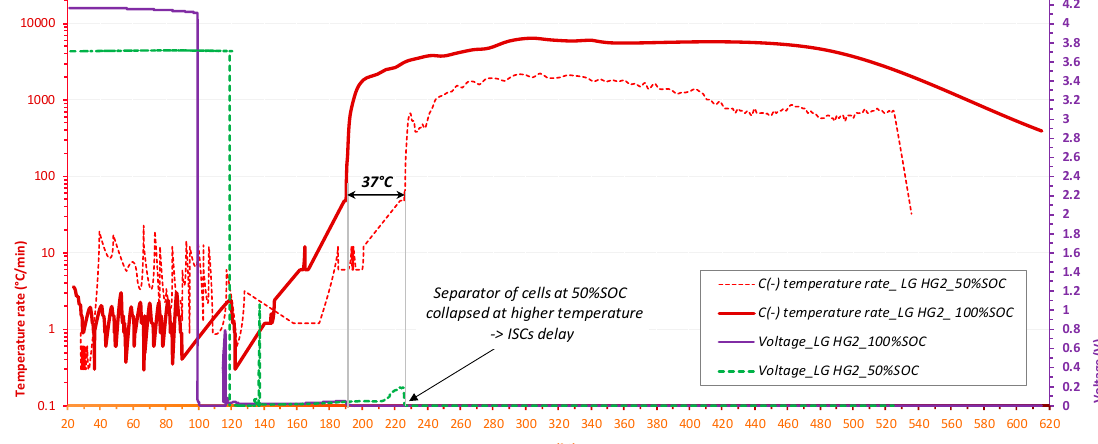
Figure 13. The C ( − ) temperature rate and voltage of LG HG2 at 50% and 100% SOC versus C ( − ) temperature.